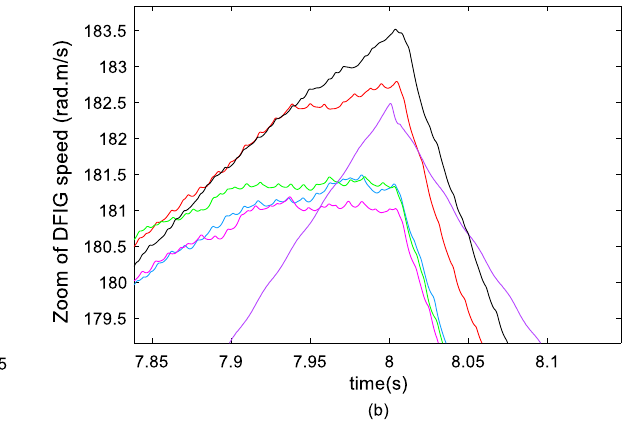
Fig. 19 a DFIG speed during symmetrical voltage sag; b zoom of